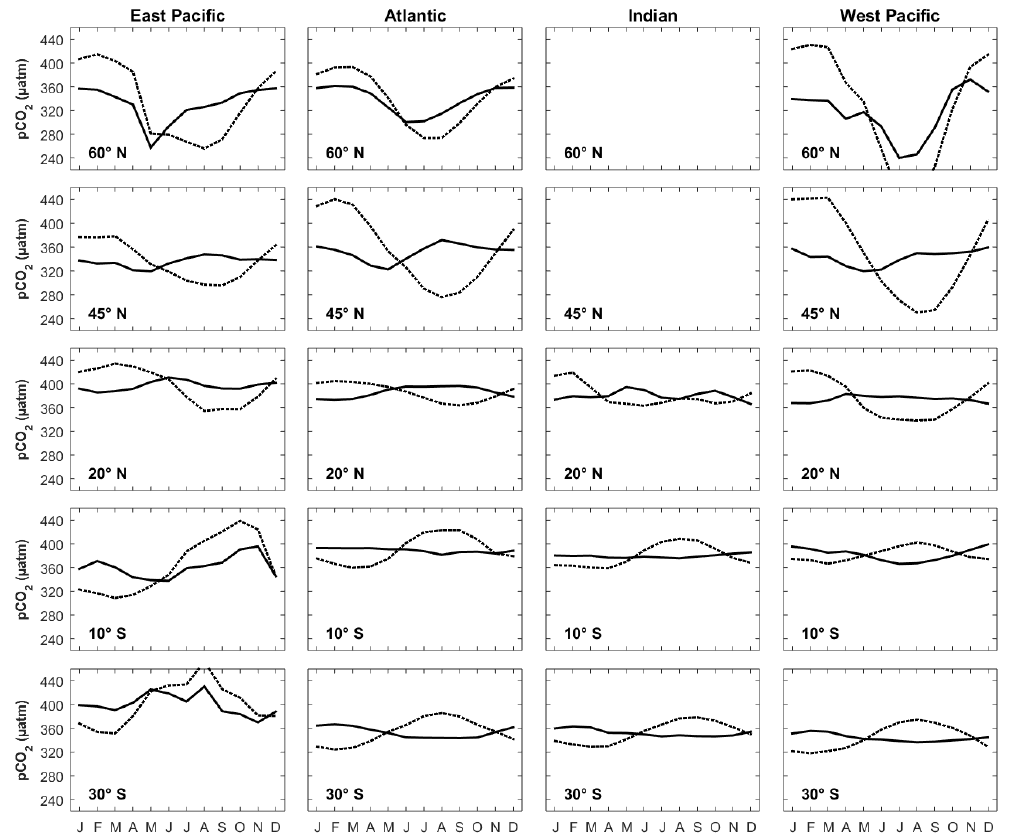
Figure 9. Seasonal cycle of observed (continuous lines) and temperature normalized p CO 2 ( p CO 2 ( SSTmean ) dashed lines) at five different latitudes in four oceanic